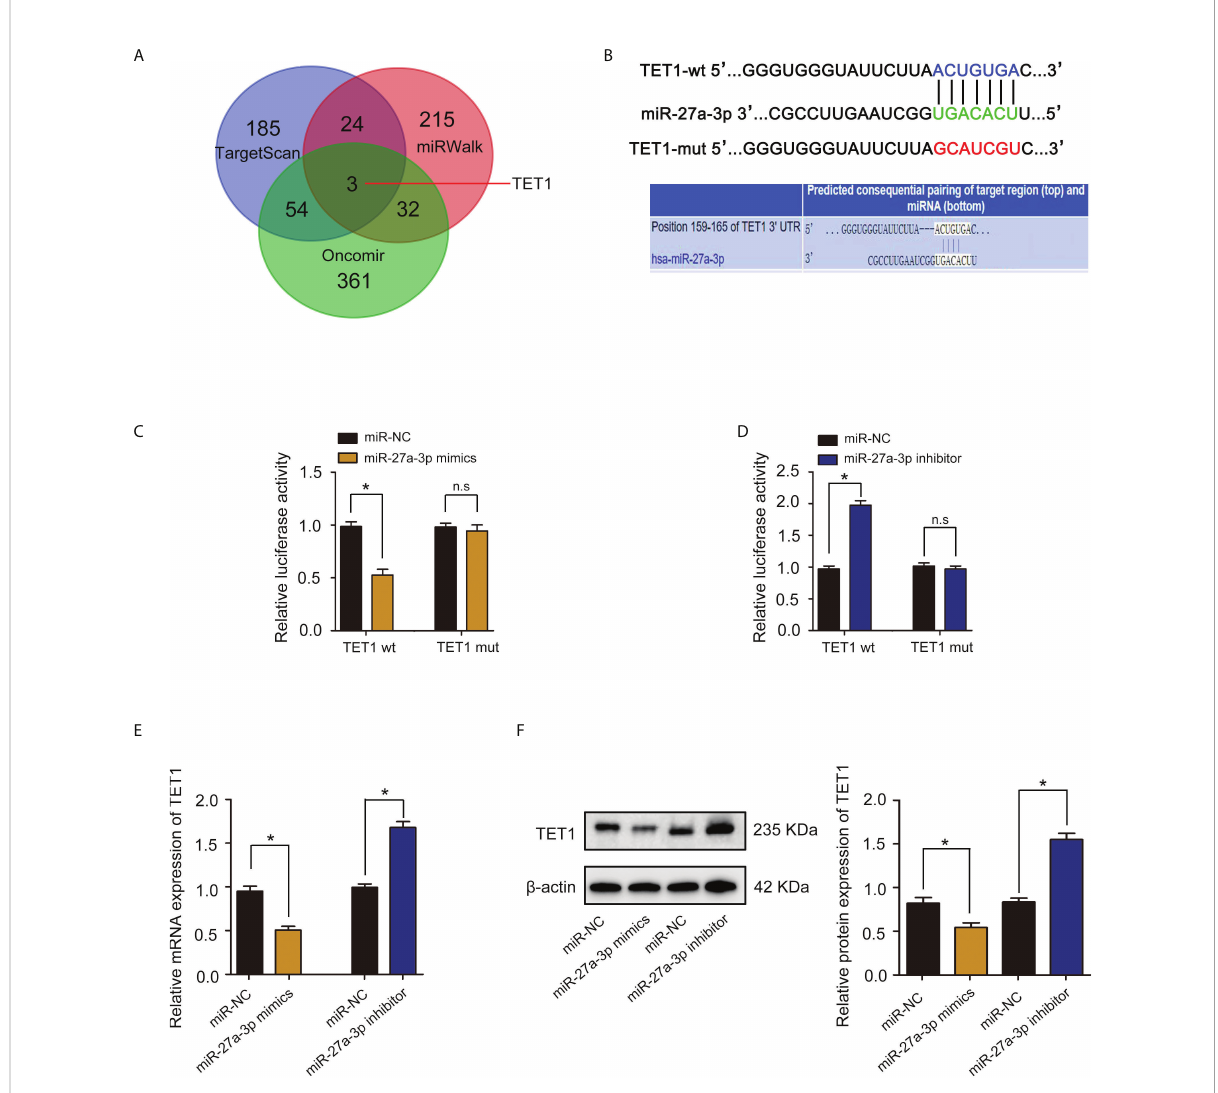
FIGURE 7 miR-27a-3p directly targets TET1 and downregulates TET1. (A) Venn diagram displaying miR-27a-3p computationally predicted to target TET1 by TargetScan, Oncomir, and miRWalk databases. (B) The binding sites and corresponding mutant sites of miR-27a-3p and TET1 3 ’ UTR. (C) A dual luciferase activity assay was performed by cotransfection of luciferase reporter containing TET1 3 ’ UTR or the mutant reporter with miR-27a-3p mimics. *p < 0.05 versus controls. n.s > 0.05 versus controls. (D) A dual luciferase activity assay was performed by cotransfection of luciferase reporter containing TET1 3 ’ UTR or the mutant reporter with miR-27a-3p inhibitor. *p < 0.05 versus controls. n.s > 0.05 versus controls. (E) The expression of TET1 detected by qRT – PCR. *p < 0.05 versus controls. (F) The protein expression of TET1 detected by western blotting. *p < 0.05 versus